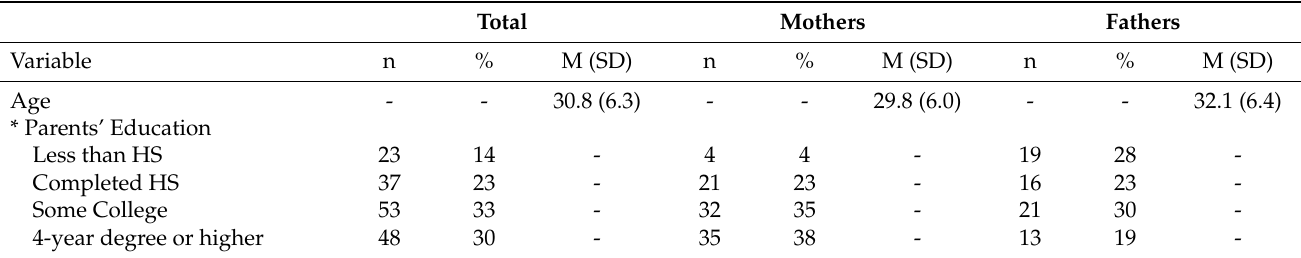
Table 1. Description of mothers’ and fathers’